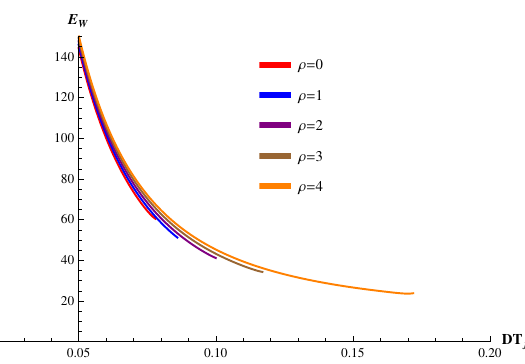
Figure 5. Variation of E W with dimensionless quantity DT f for different values of ρ . Again we see the increasing behavior of EWCS with ρ which is similar to the variation of